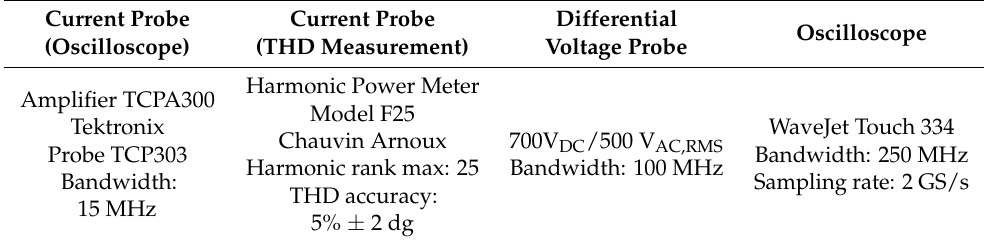
Table 3. Measurement and visualization equipment